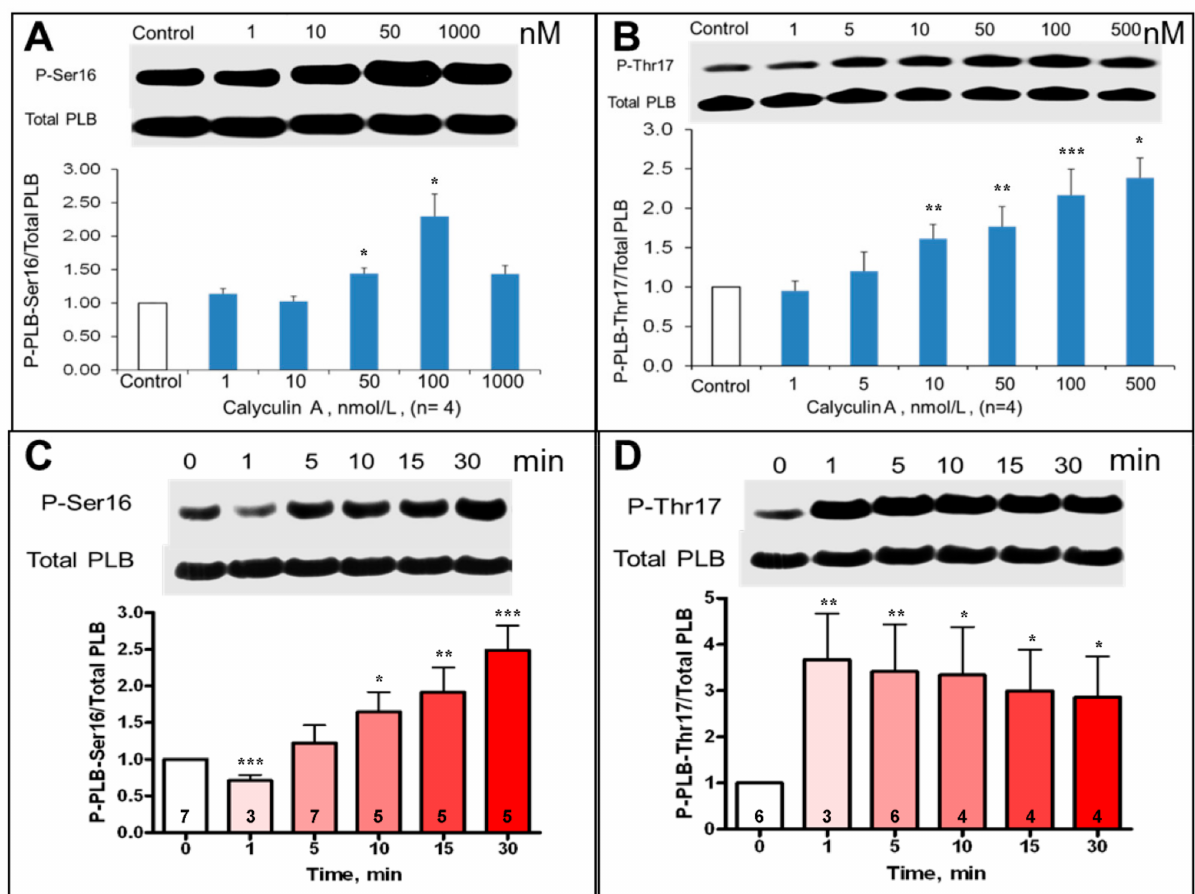
Figure 3. Average effects of CyA on the magnitude of SANC PLB phosphorylation at PKA-dependent Ser 16 and CaMKII- dependent Thr 17 sites. ( A , B ) Concentration dependence (30 min CyA treatment, n = 4). ( C , D ) Rates of phosphorylation in response to 100 nmol/L CyA. Representative Western blots of phosphorylated PLB and total PLB are presented in the upper part of each panel. Number of samples is shown in each column. * p < 0.05, ** p < 0.01, *** p < 0.001 vs.